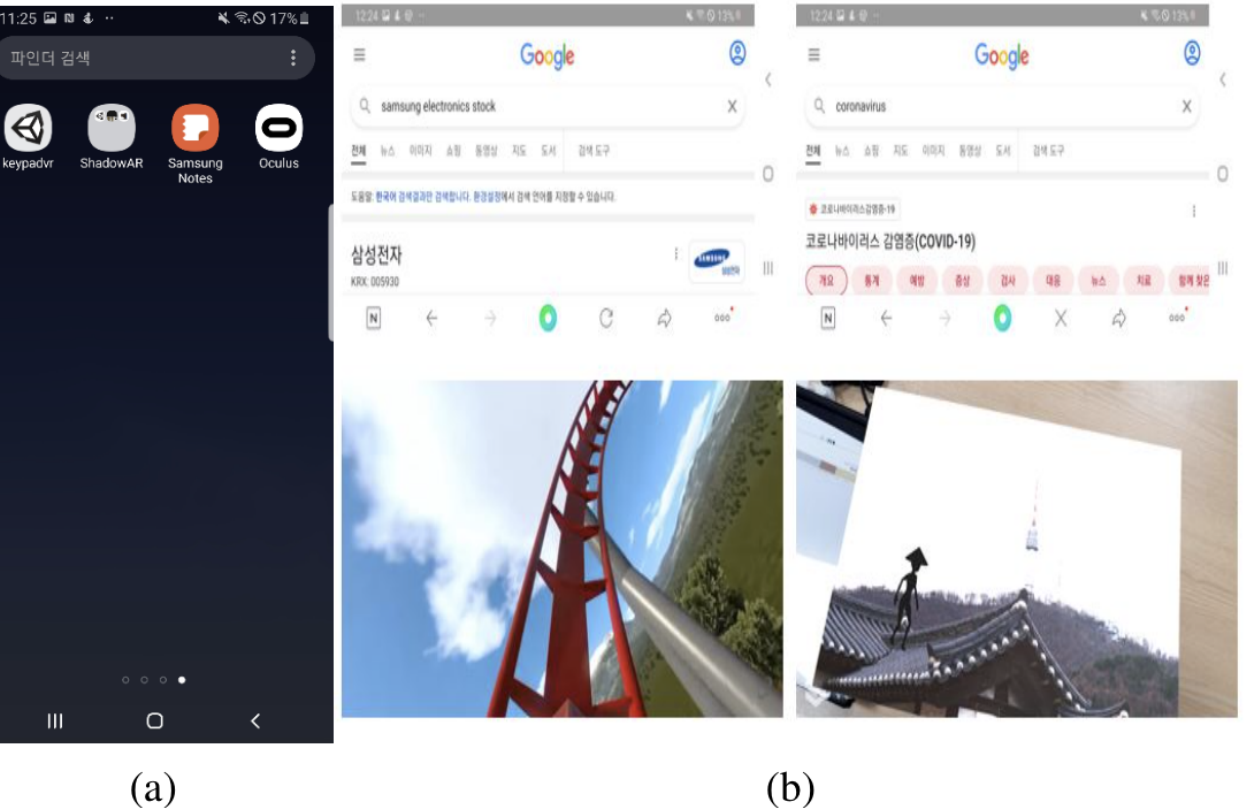
Figure 10. ( a ) The Android application management interface—3 button navigation in the bottom of the smartphone, and ( b ) scenes from some of the tested multi-tasked applications (available by touch selection in the App overview in the phone screen) in Experiment 2—web/Google search (upper part of the phone screen) for “Samsung Electronics” (left) and “COVID-19” (right) in Korean, and VR/AR applications (lower part of the phone